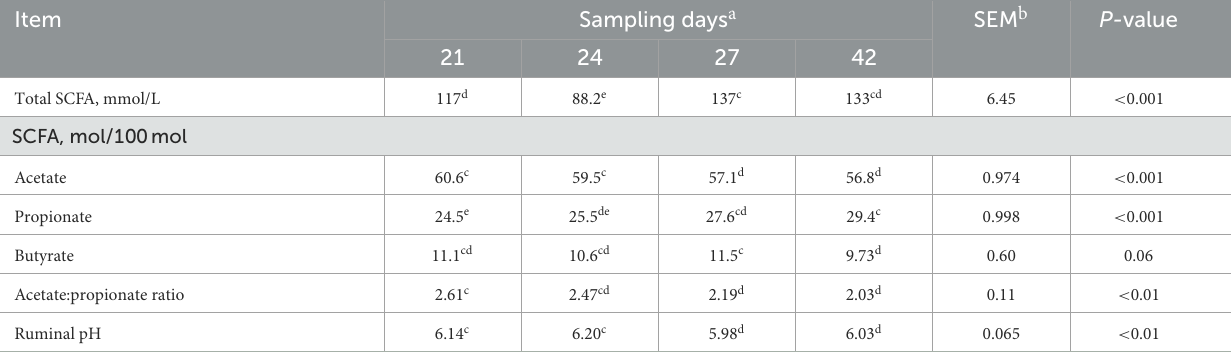
TABLE 5 Effect of sampling days on the ruminal concentration of short-chain fatty acids (SCFAs) and pH of finishing beef cattle—Exp. 1.